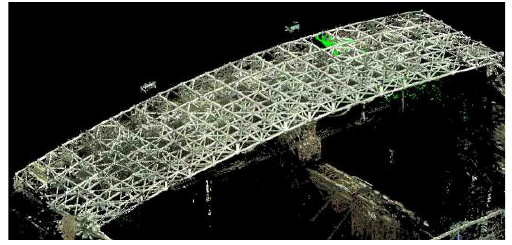
Figure8 Control network of National